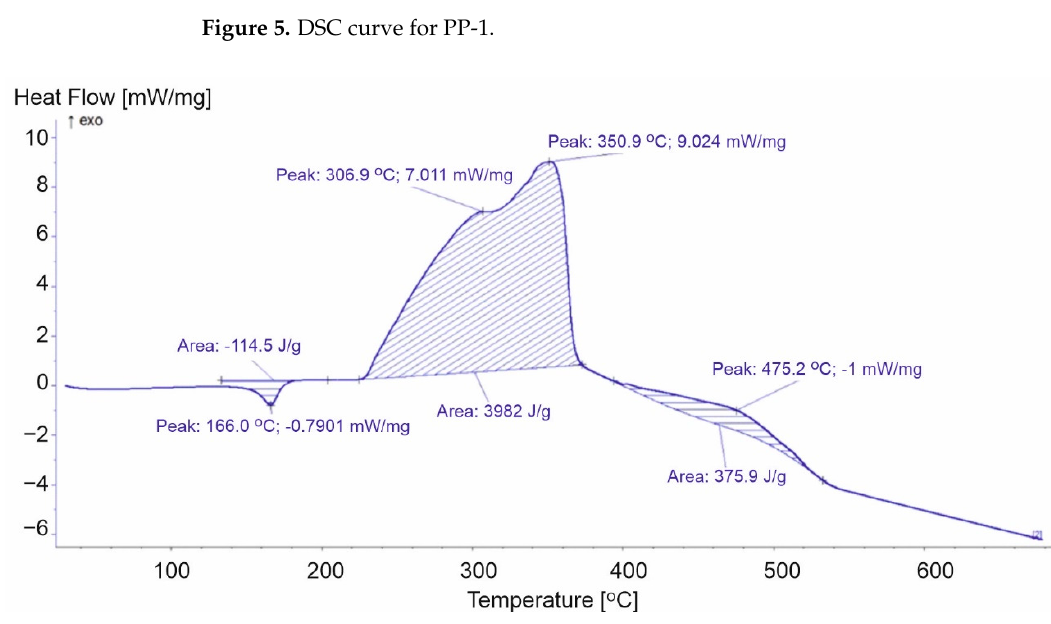
Figure 5. DSC curve for PP ‐ 1.